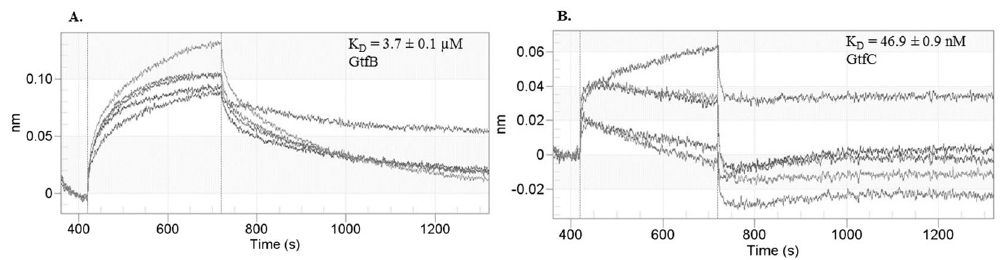
Figure 3. Binding curves of compound #G43 at varying concentrations with ( A ) GtfB, and ( B ) GtfC catalytic